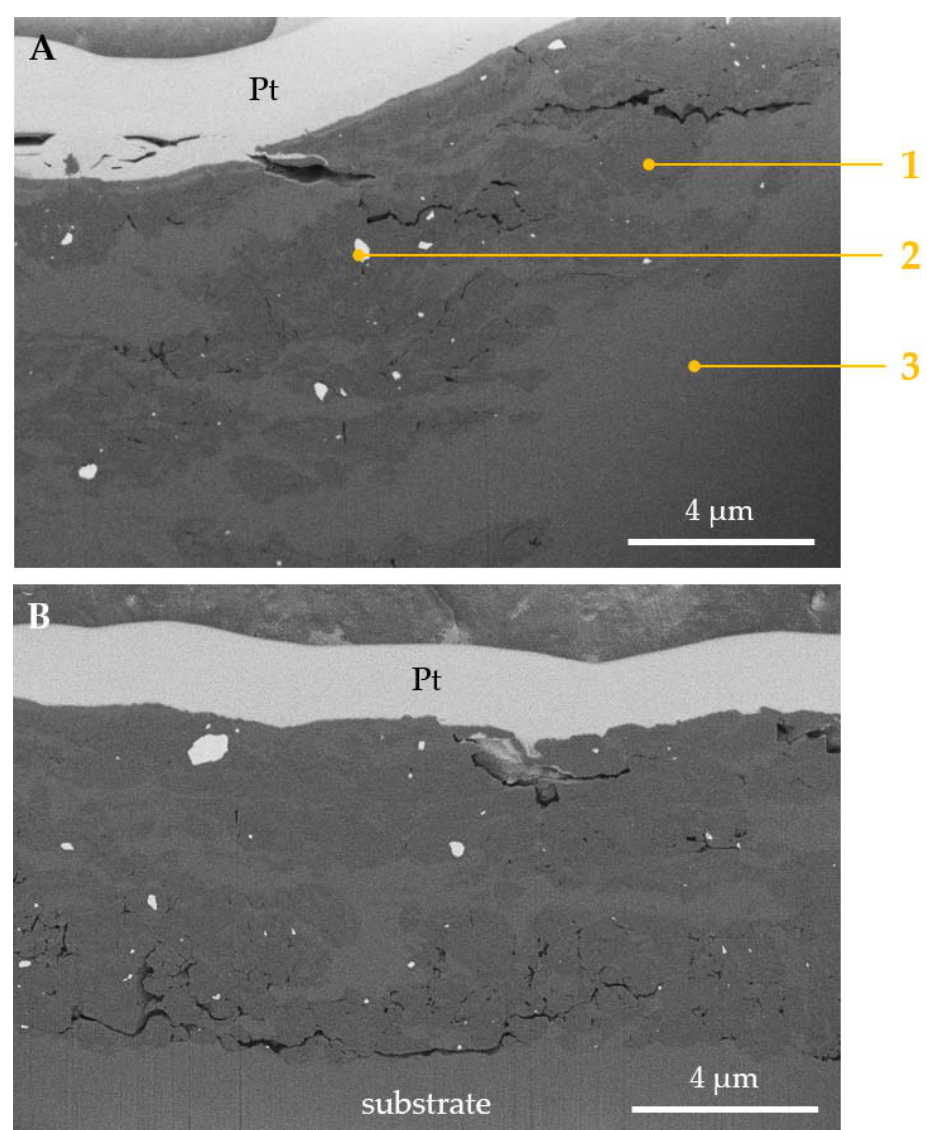
Figure 16. Backscattered electron SEM micrographs of the cross-section of a wear track, obtained on: ( A ) uncoated Ti6Al4V alloy, ( B ) TiN-coated Ti6Al4V alloy. The cross-sections were prepared with the use of FIB.